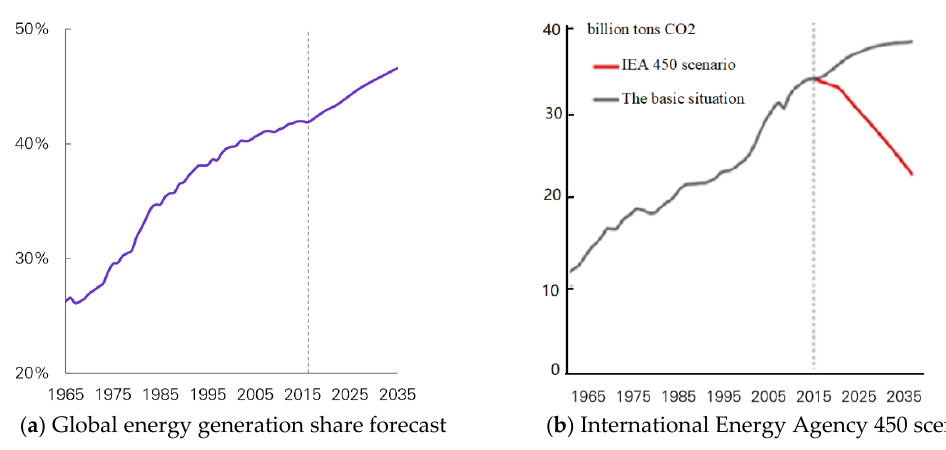
Figure 1. Global carbon emissions projections compared to 450 deployment scenarios.